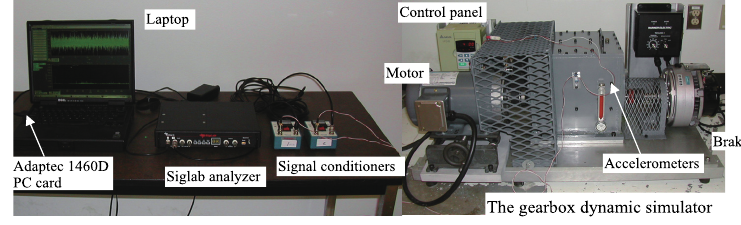
Fig. 4. The experimental apparatus of gearbox testing